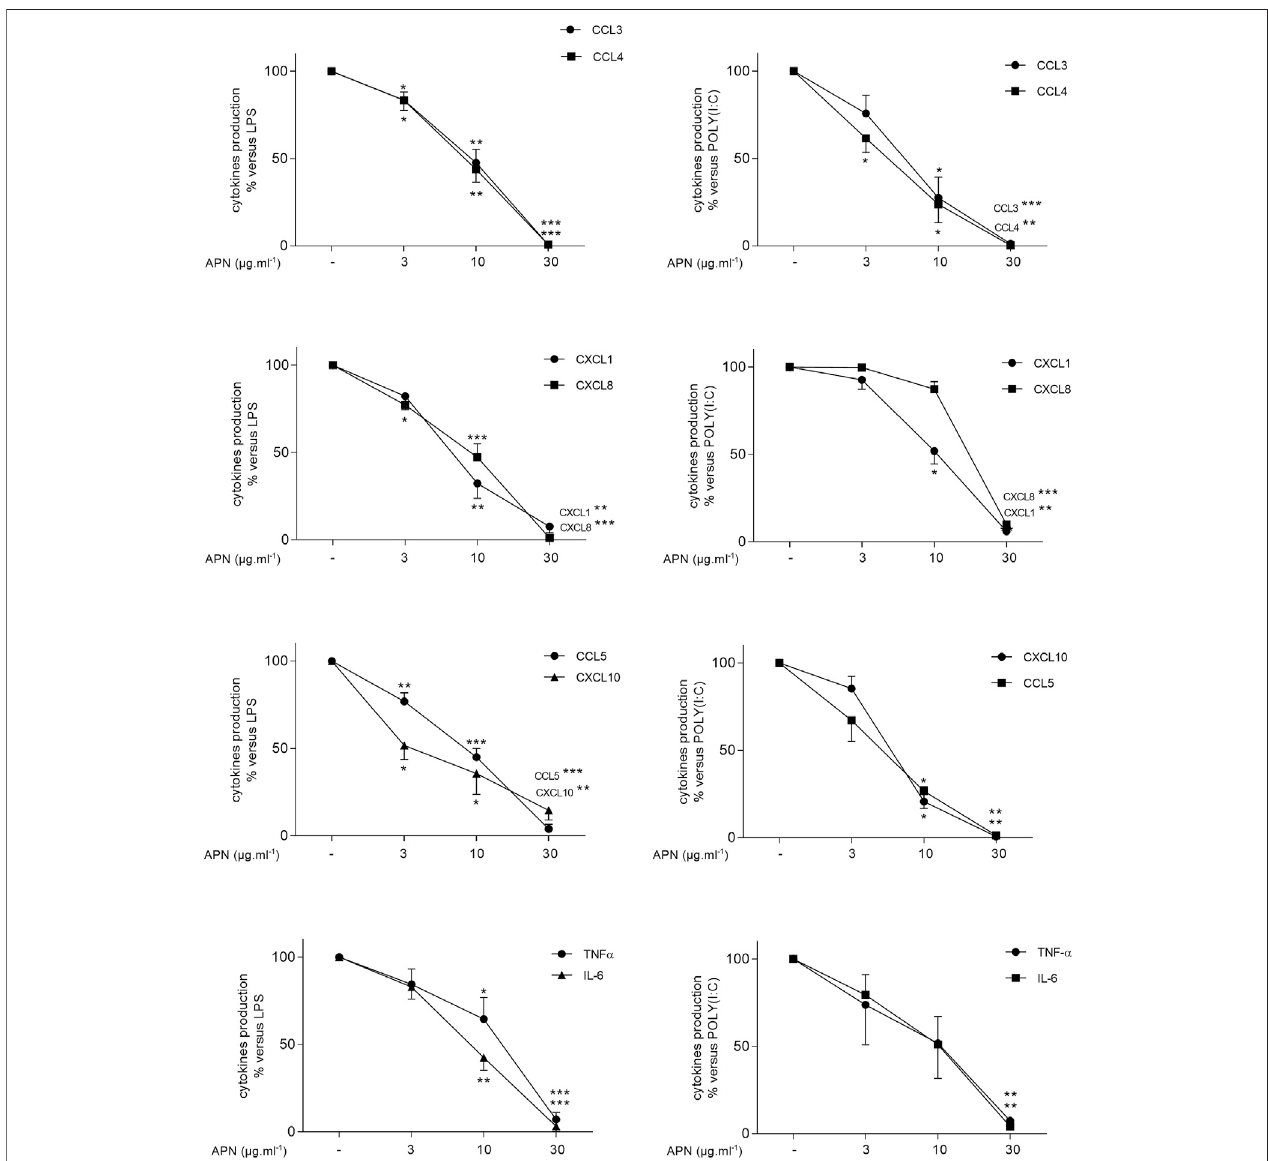
FIGURE 5 | Inhibitory effects of APN on the LPS- or poly(I:C)-induced cytokine release by human LMs. Macrophages were incubated with LPS (10 ng ml − 1 , left column)orpoly(I:C)(10 µg ml − 1 ,rightcolumn)intheabsenceorpresenceofAPN(3,10or30 µg ml − 1 )for24 h.DataareexpressedasapercentagewithrespecttoLPS orpoly(I:C)-inducedproduction.Resultsareshownasthemean ± SEMof5 – 16differentexperiments.Asterisksindicatesigni fi canteffectsofAPNwithrespecttoLPSor poly (I:C) alone (*: p < 0.05; **: p < 0.01; ***: p < 0.001).